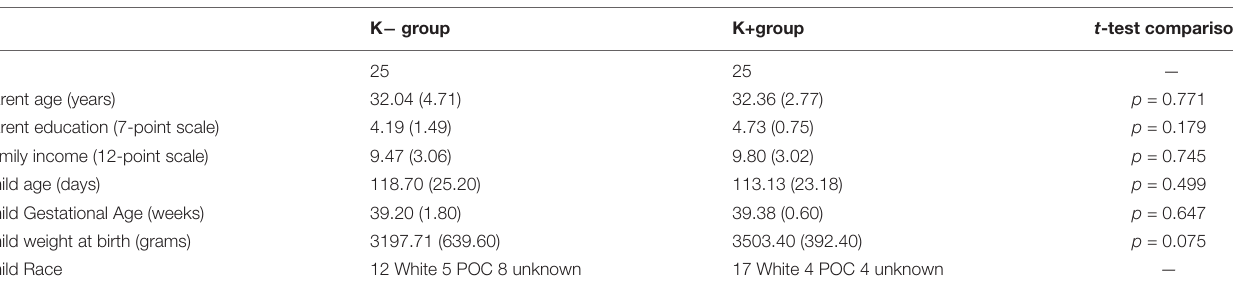
TABLE 1 | Participant demographic